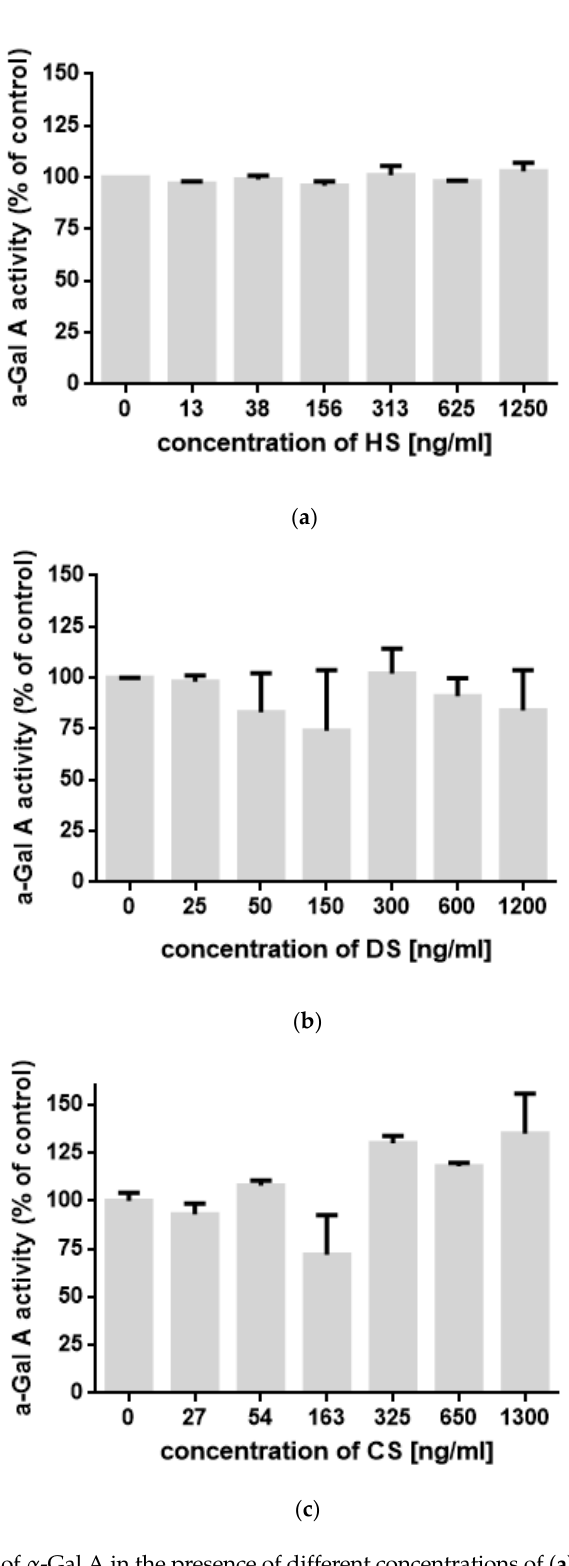
Figure 4. The activity of α-Gal A in the presence of different concentrations of ( a ) heparan sulfate (HS), ( b ) dermatan sulfate (DS), and ( c ) CS. Presented results are mean values from three independent experiments, with SD indicated as error bars. No statistically significant differences (at p < 0.05) were detected between control experiments (no GAGs added) and any measurements in the presence of GAGs.